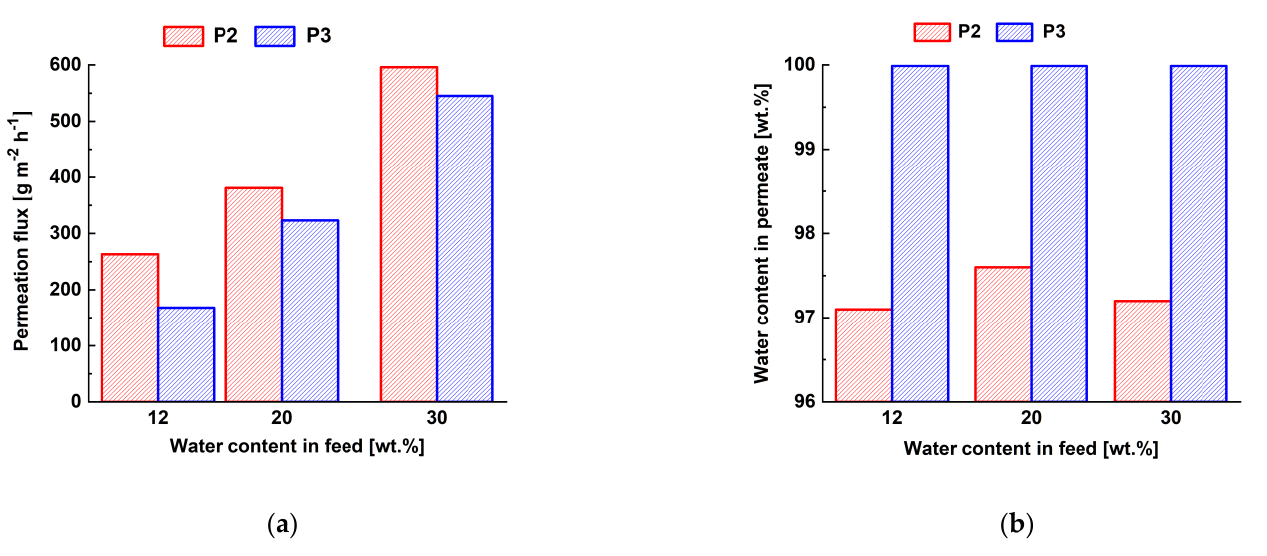
Figure 11. Dependence of permeation flux ( a ) and water content in permeate ( b ) on the water content in feed mixture during the pervaporation of isopropanol/water mixture (12–30 wt.% water) for TFC ChS/PAN membrane prepared by physical adsorption.